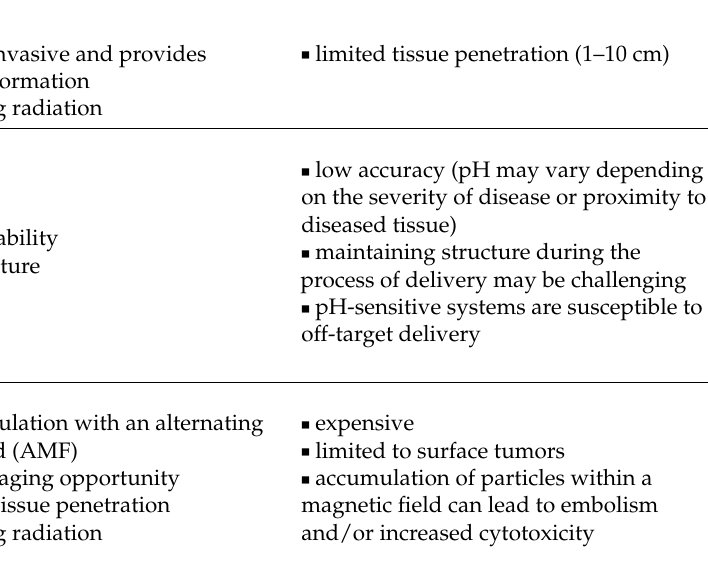
Table 1. The advantages and disadvantages of drug delivery trigger mechanisms.